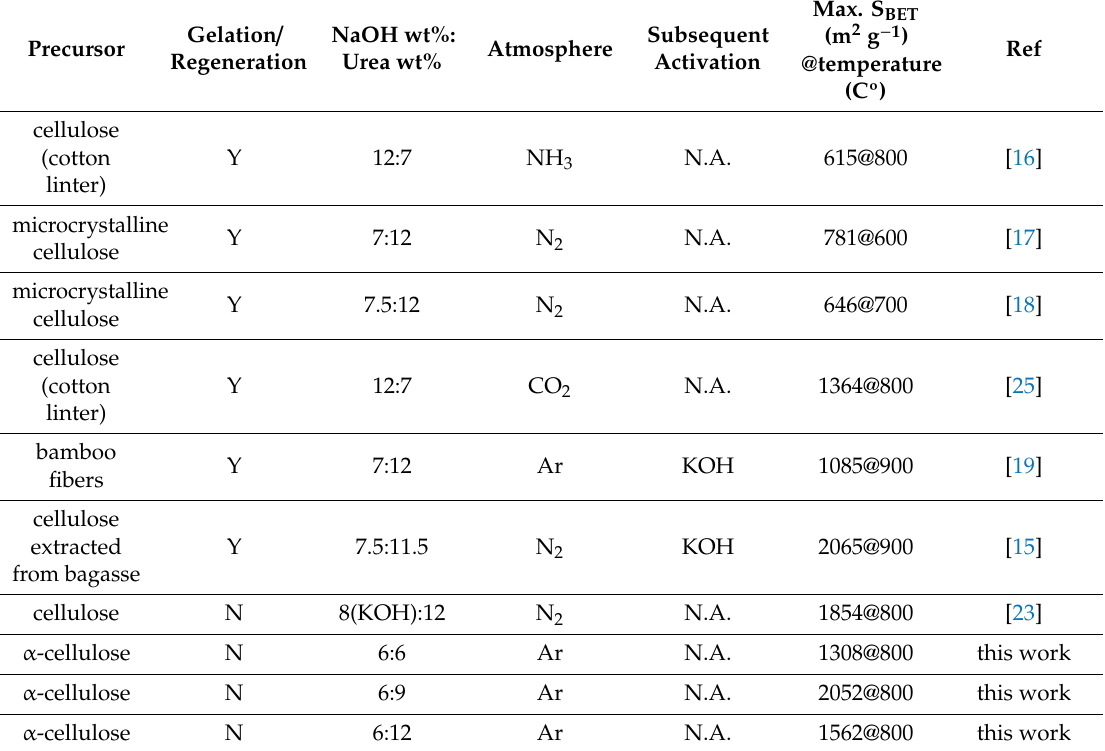
Table 1. Comparison of Brunauer-Emmett-Teller (BET) surface area of cellulose derived porous